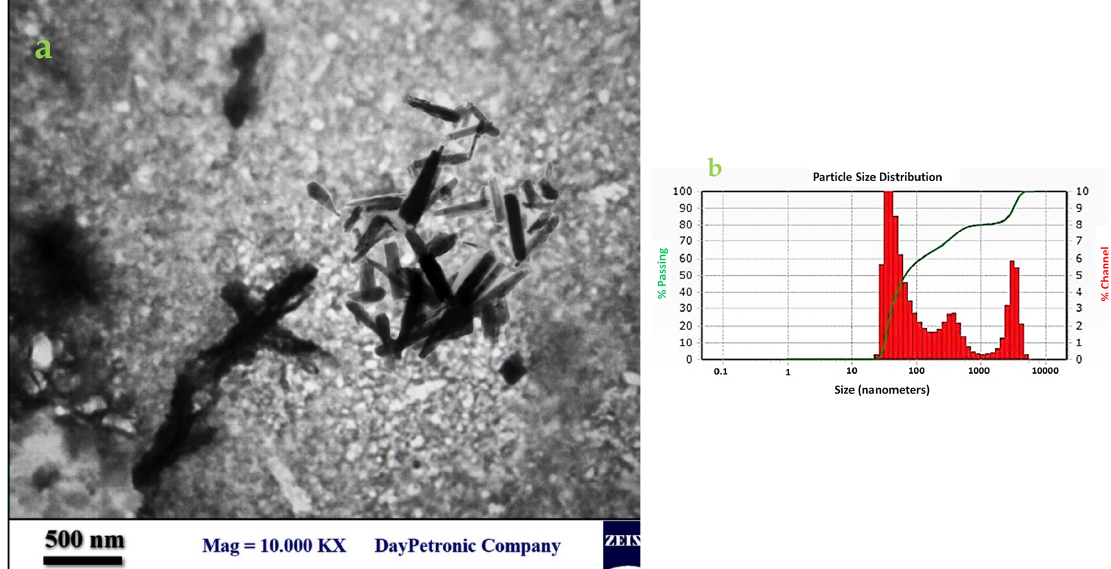
Figure 7. TEM image of the ZnO nanorods (a) and the size distribution chart using particle size analyzer (b). Average particle size distribution plot (red) size vs. % channel (green) size vs. % passing. % Passing-Cumulative values of each size of particles from 0 to 100 %; % Channel-Size distribution values for each size of particles.